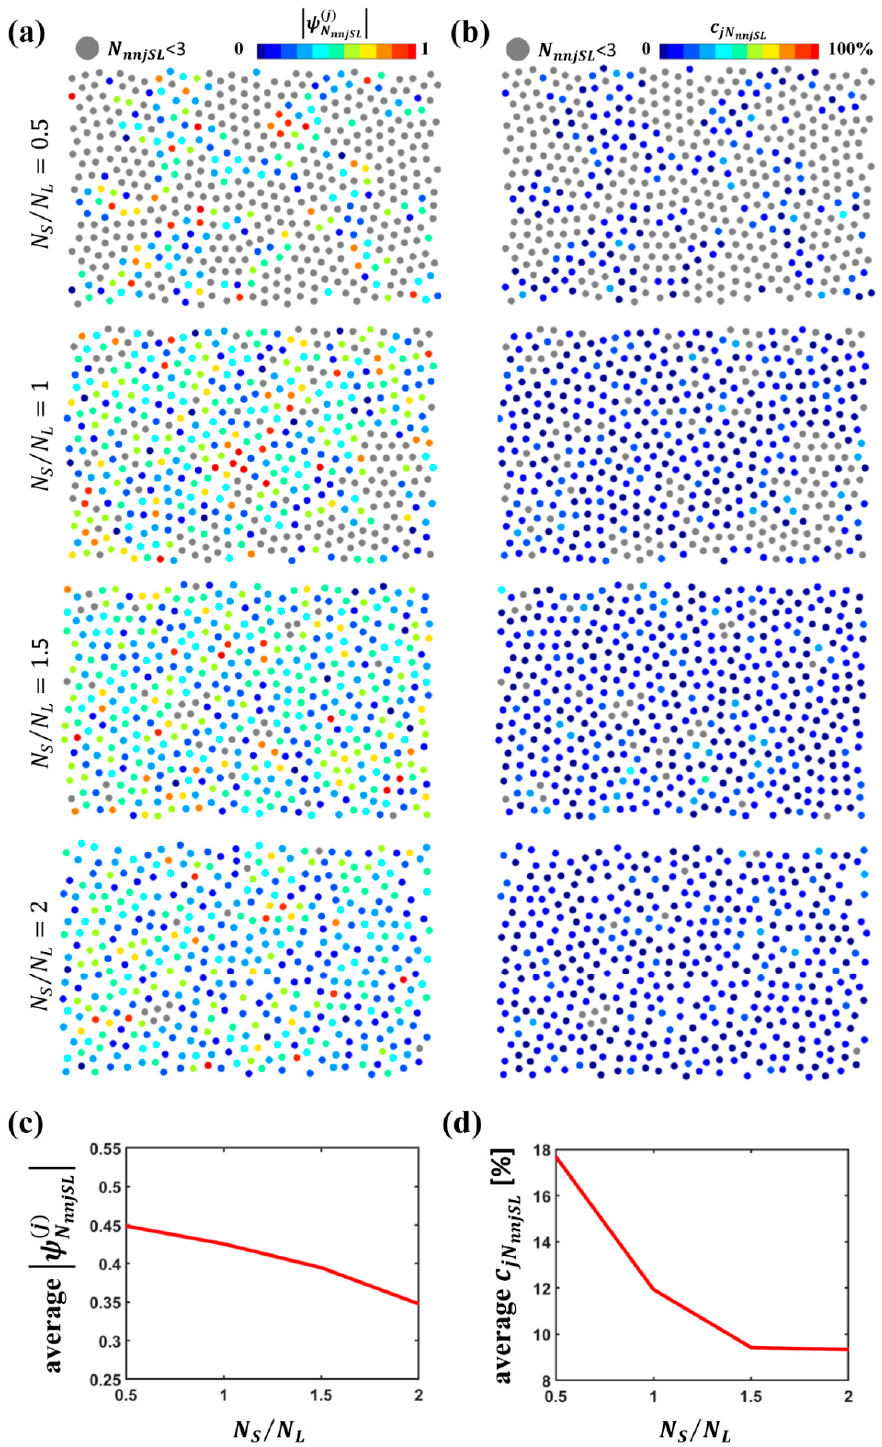
Figure 9. Angular and radial uniformity of S particles with respect to L particles: ( a ) Identification of angular uniformity and color-coded representation of (cid:4698)ψ (cid:2898) N S /N L for L particles surrounded by at least three S nearest neighbors; ( b ) identification of radial uniformity and color-coded representation of c jN particles surrounded by at least three S nearest neighbors; ( c ) average value of (cid:4698)ψ (cid:2898) particle number ratio N S /N L ; ( d ) average value of c jN